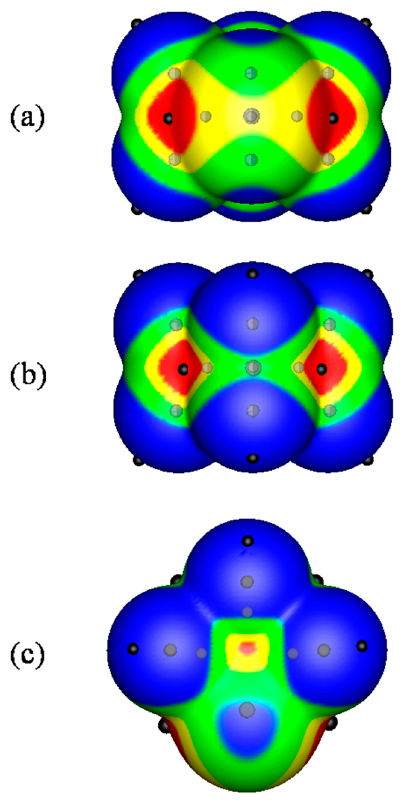
Figure 3. Computed electrostatic potential on the 0.001 au molecular surface of hexafluorothiacyclobutane, 5 . In ( a ), the sulfur is in the foreground, with CF 2 groups behind it on both sides. In ( b ), a CF 2 group is in the foreground, the other two being behind it on both sides; the sulfur is in the rear, not visible. In ( c ), the view is from above the four-membered ring. F 2 C F C CF 2 2 S